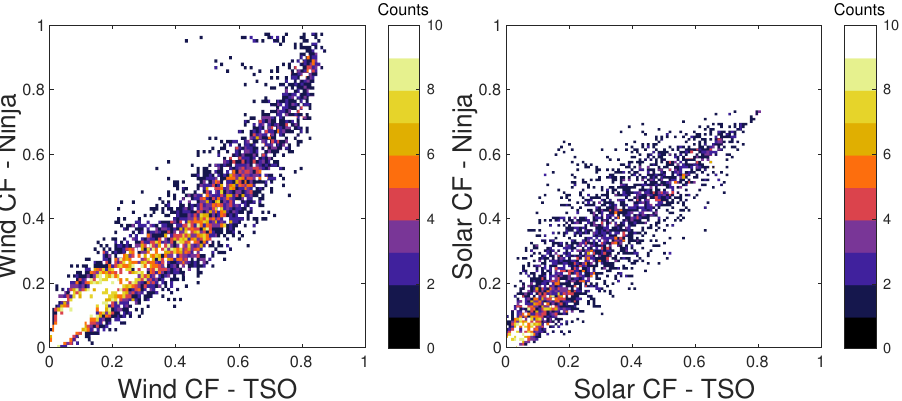
Figure 2. Bi-variate histograms of modeled and actual wind ( left panel) and solar ( right panel) power capacity factors (CF) for 2016 in